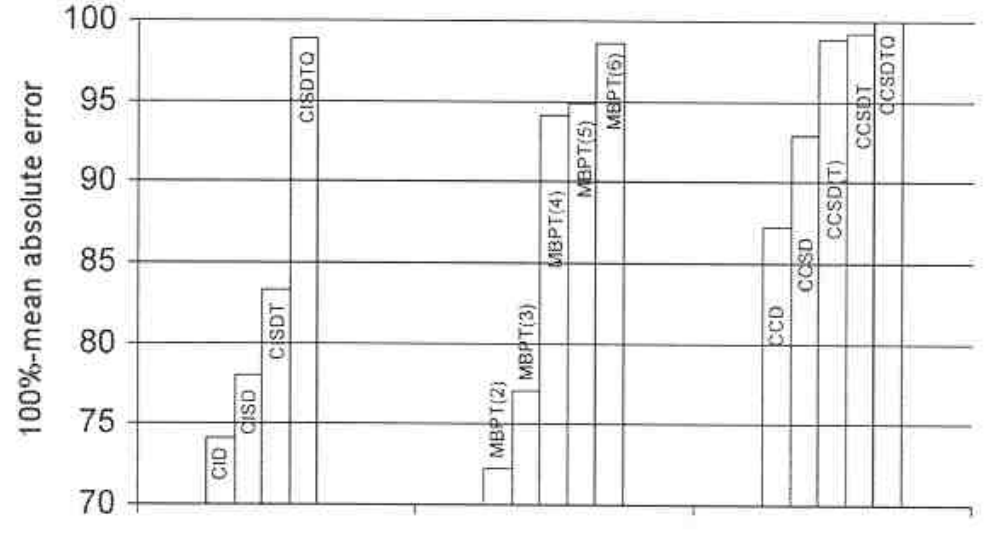
Figure 1: Differences in correlation energies for various CI, MBPT, and CC methods with respect to the full CI (average of BH, HF, H 2 O at Re, 1.5Re, 2.0Re, DZP